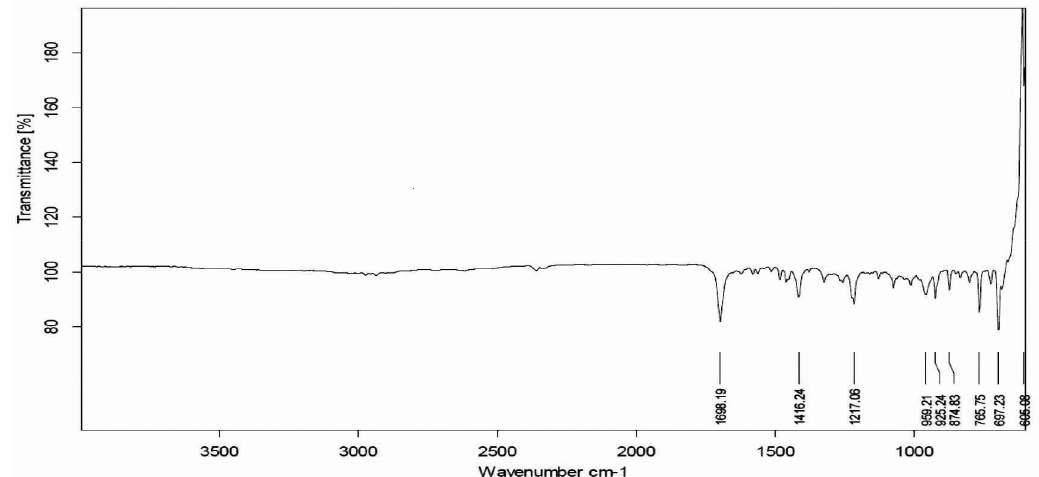
FIGURE 3 - FTIR spectrum of tablet (F9) containing flurbiprofen after